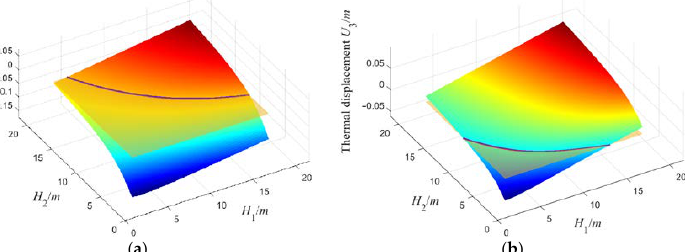
Figure 12. Thermal displacement with variable H 1 and H 2 in ( a ) a hexagonal hourglass lattice; and